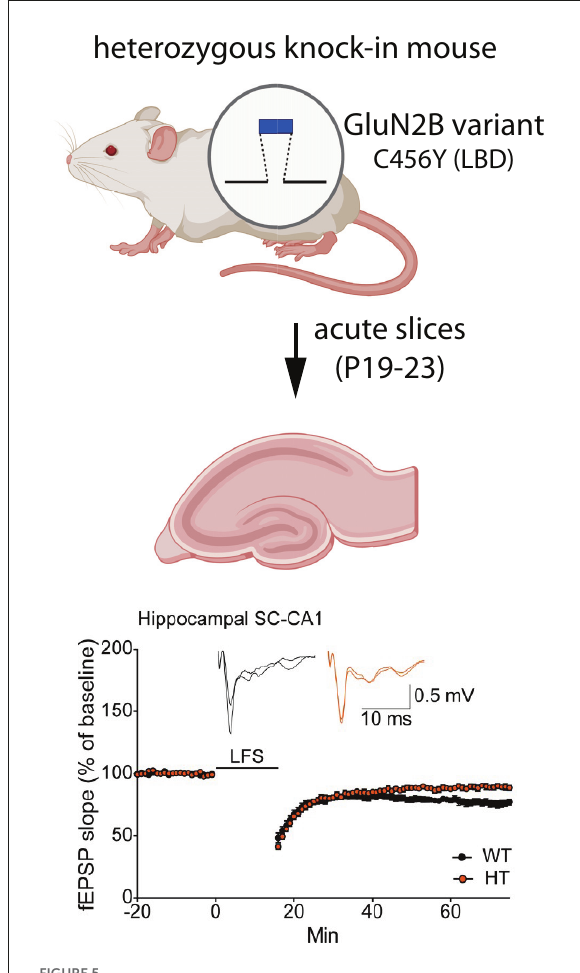
FIGURE5 Expression of a GluN2B variant reduces LTD. Mice were generated that were heterozygous for the disease-associated missense variant, C456Y, in the LBD (Shin et al., 2020). At postnatal day 19–23, field EPSPs (fEPSPs) were recorded from CA1 neurons in acute hippocampal slices. Neurons expressing the C456Y variant had impaired NMDAR-dependent LTD, induced by low frequency stimulation (LFS). Synapse density and postsynaptic ultrastructure were unaffected. Illustrations were partially created with BioRender.com. Recordings are from Shin et al.